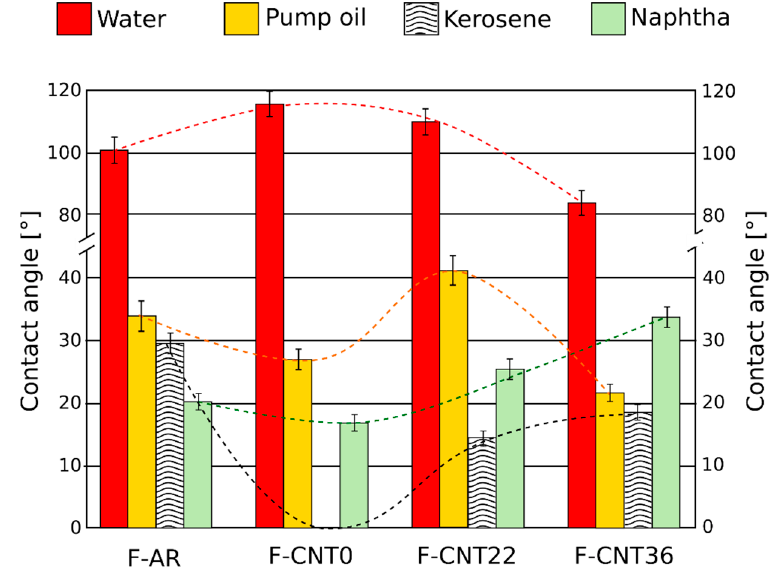
Figure 9. The contact angle of different liquids for all foams.